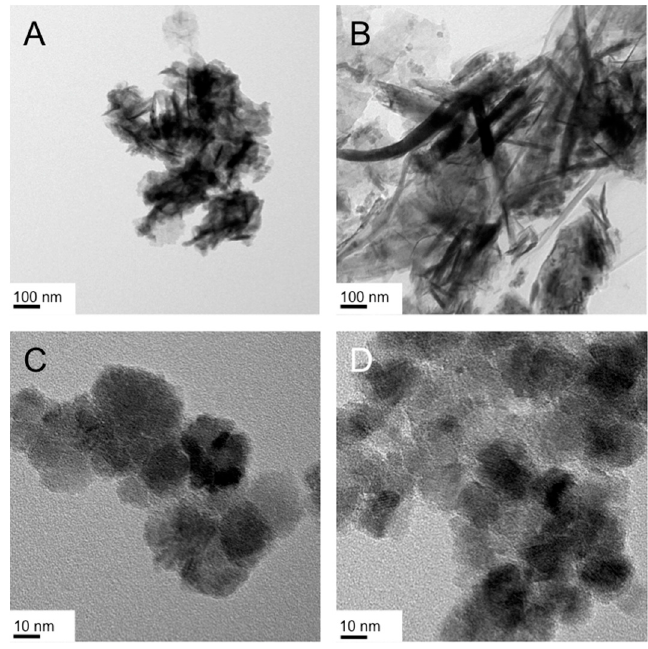
Figure 10. TEM images of the IO nanostructures obtained from the reduction/hydrolysis reaction of FeCl 3 in the isotropic micellar liquid (rod-like micelles) formed by CTAB (20 wt %) in water at 60 °C: ( A , B ) froth fraction and ( C , D ) gel fraction.